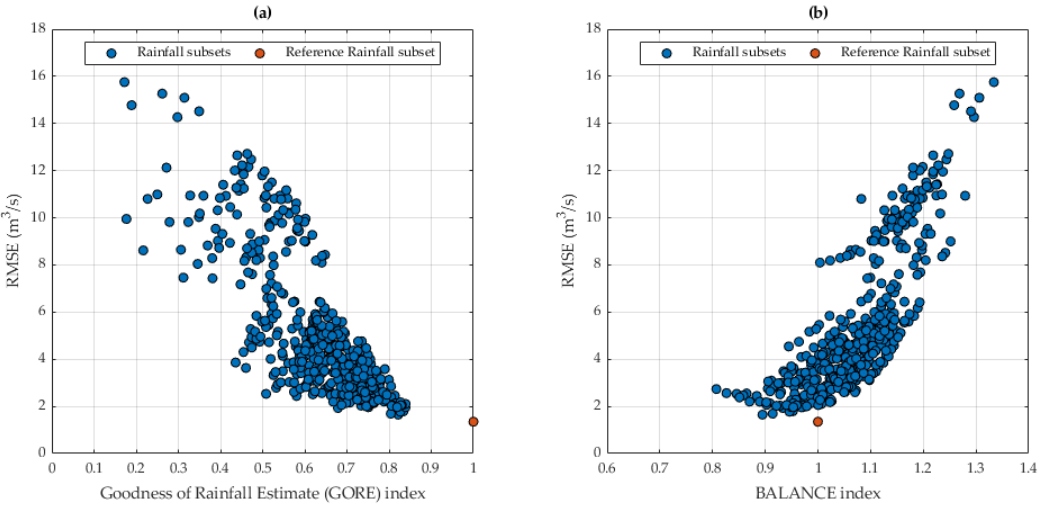
Figure 10. Impact of the quality of rainfall estimate on the modular model in calibration period. ( a ) Goodness of Rainfall Estimate (GORE) index value and ( b ) BALANCE index values.